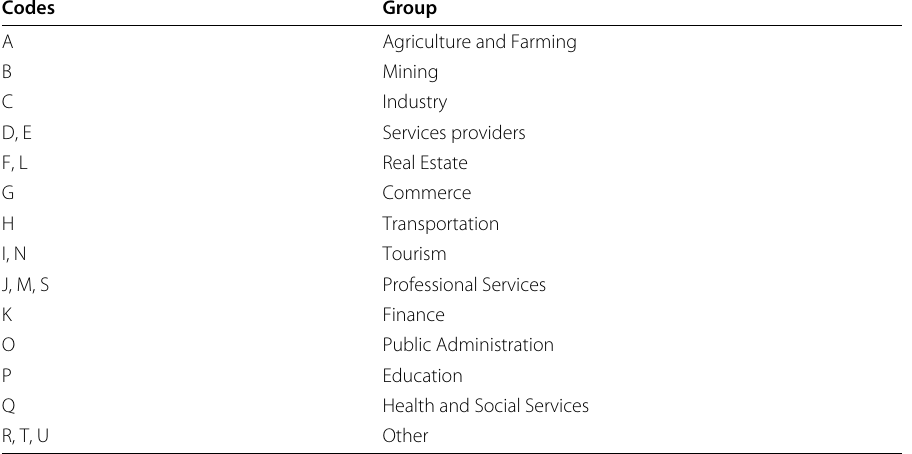
Table 1 Conversion table between NACE codes and groups used in this work